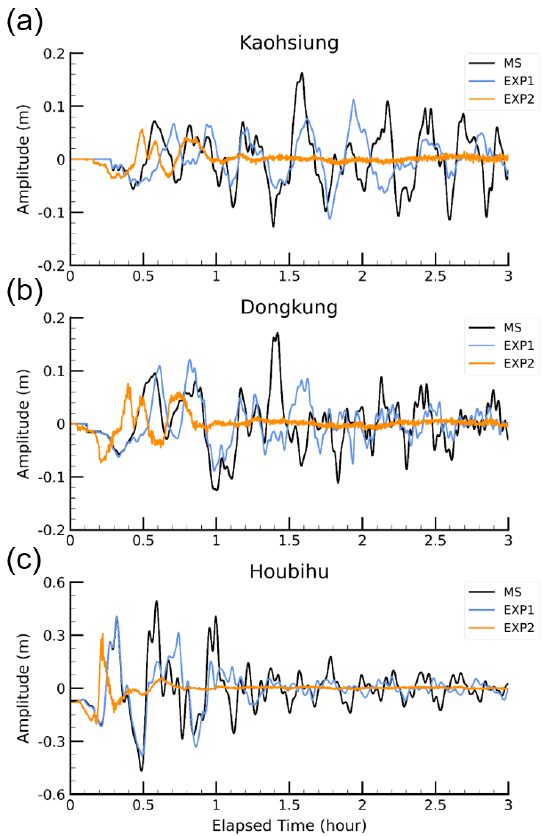
Figure 25. Simulated tsunami waveforms at the (a) Kaohsiung, (b) Dongkung, and (c) Houbihu stations from numerical experi- ments MS, EXP1, and